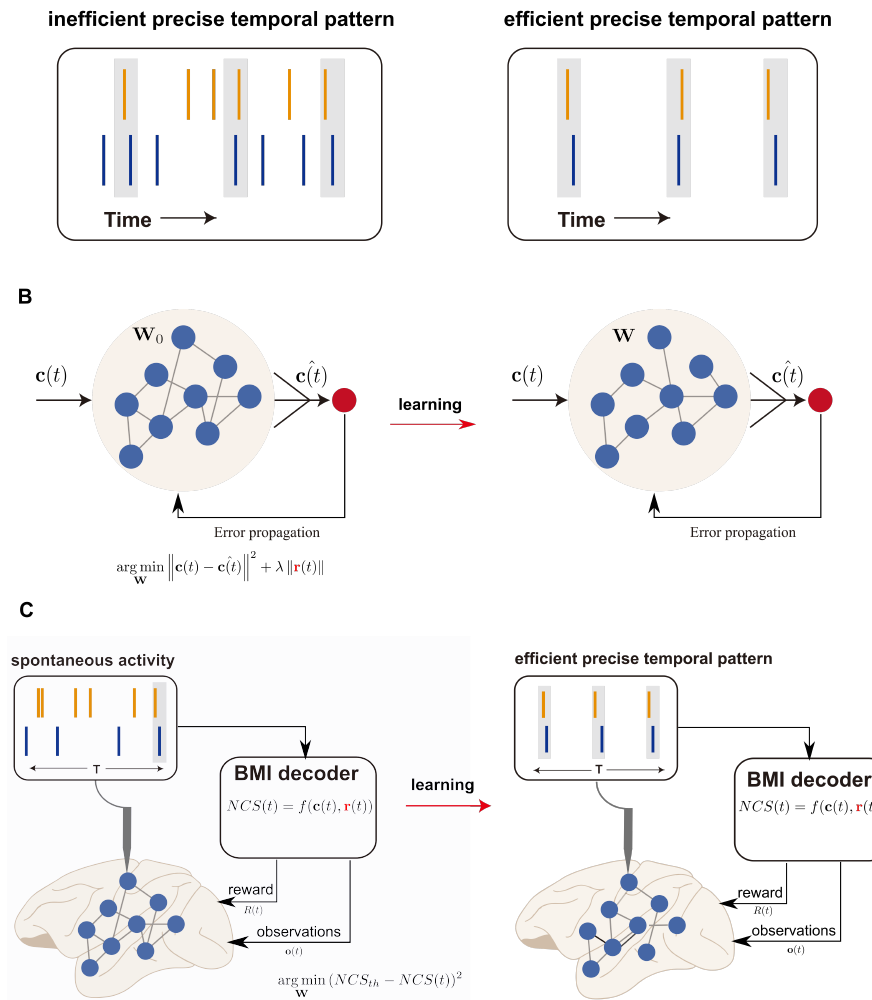
Figure 1. Schematic of precise temporal codes. ( A ) Schematic illustrating two types of precise temporal codes. Shaded rectangles mark the precise synchronization beyond rate fluctuation that is preserved in the spike trains of two neurons. However, the efficient precise temporal pattern depicted on the right contains less spikes than that on the left , although the number of spiking coincidences under the two cases is identical. ( B ) Schematic of how efficient codes are studied on artificial neural networks by explicitly incorporating the regularization term into the cost function in order to penalize high firing rates r ( t ) . Here, c ( t ) denotes the target signals to be represented by the network. ( C ) Schematic of the explicit incorporation of information capacity c ( t ) and metabolic cost (neurons’ firing rates r ( t ) ) in the decoder of the brain–machine interface for the study of the efficient codes in vivo. NCS ( t ) is the decoded variable defined in this